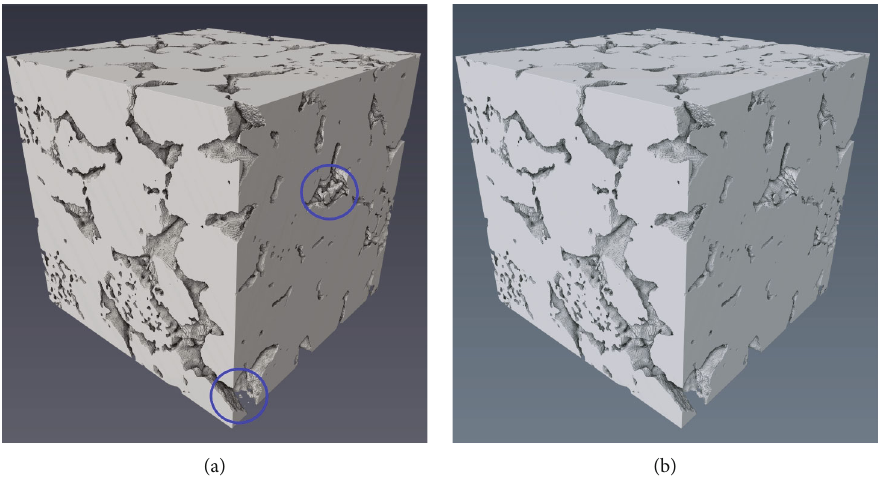
Figure 11: (a) Digital core c and (b) corrected digital core c.